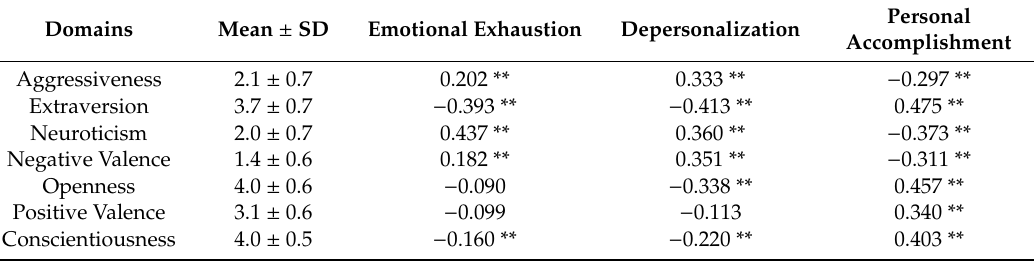
Table 4. Correlations between personality traits and burnout.